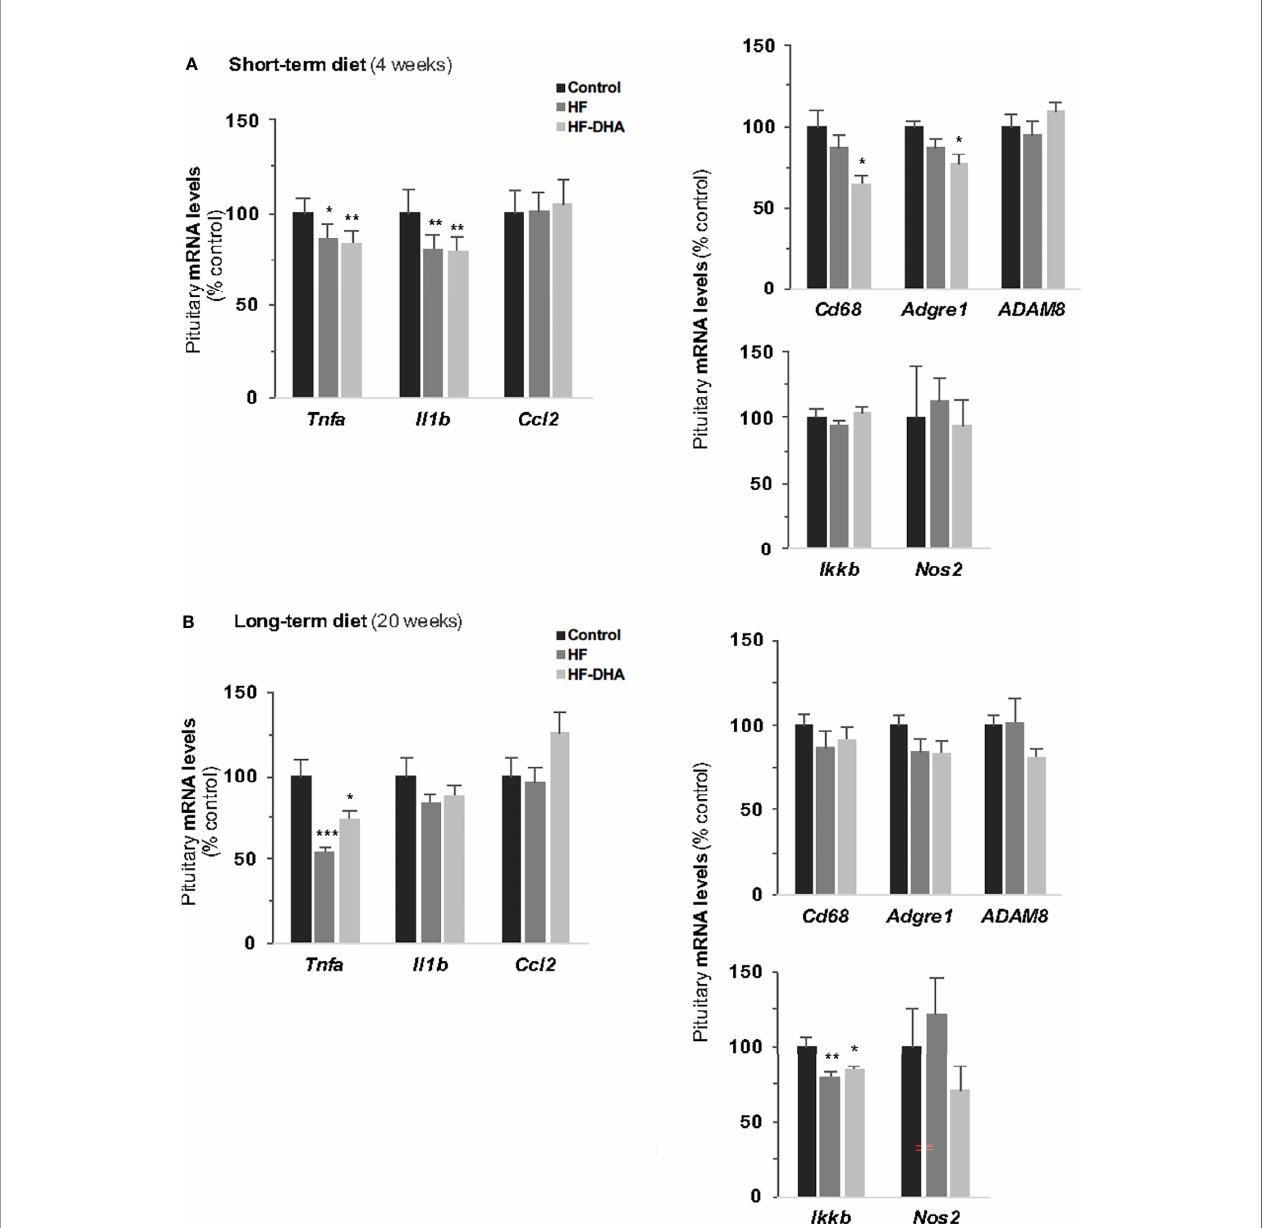
FIGURE 4 | Pituitary in fl ammation in rats after short-term or long-term high-fat diets. Transcript levels of pro-in fl ammatory cytokines ( Tnfa , Il1b , Il6, Ccl2) , in fl ammation-related ( Ikkb and Nos2 ) and macrophage ( Cd38 , Adgre1 , Adam8 ) genes in pituitaries of rats fed control, HF or HF-DHA diets for 4 (A) or 20 weeks (B) . Transcript levels were determined and expressed as indicated in Figure 2B . Data are expressed as means ± SEM (n= 6-8 rats) and were analyzed with Kruskal- Wallis test followed by Dunnett ’ s multiple comparison test. * P ≤ 0.05; ** P ≤ 0.01; *** P ≤ 0.001 vs respective